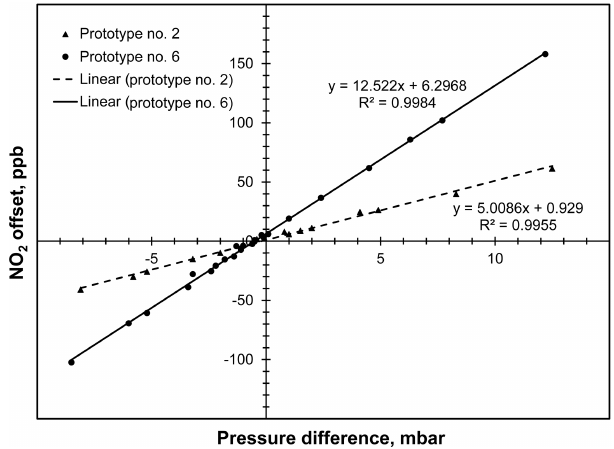
Figure 4. Plot of data obtained for two prototypes of the folded tubular photometer showing the analyzer offset inppb of NO 2 as a function of the measured pressure difference ( P I – P Io ) between a sample bypassing the NO x scrubber ( I) and a sample passing through the NO x scrubber ( I o